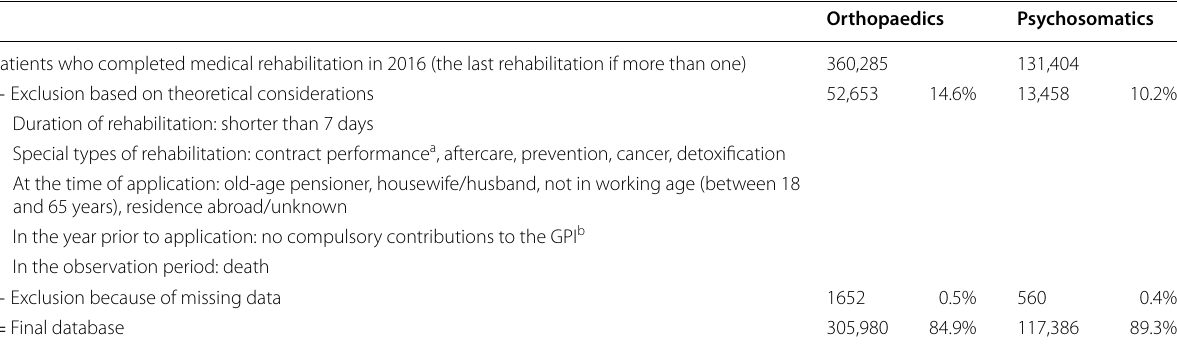
Table 1 Number of cases and exclusion